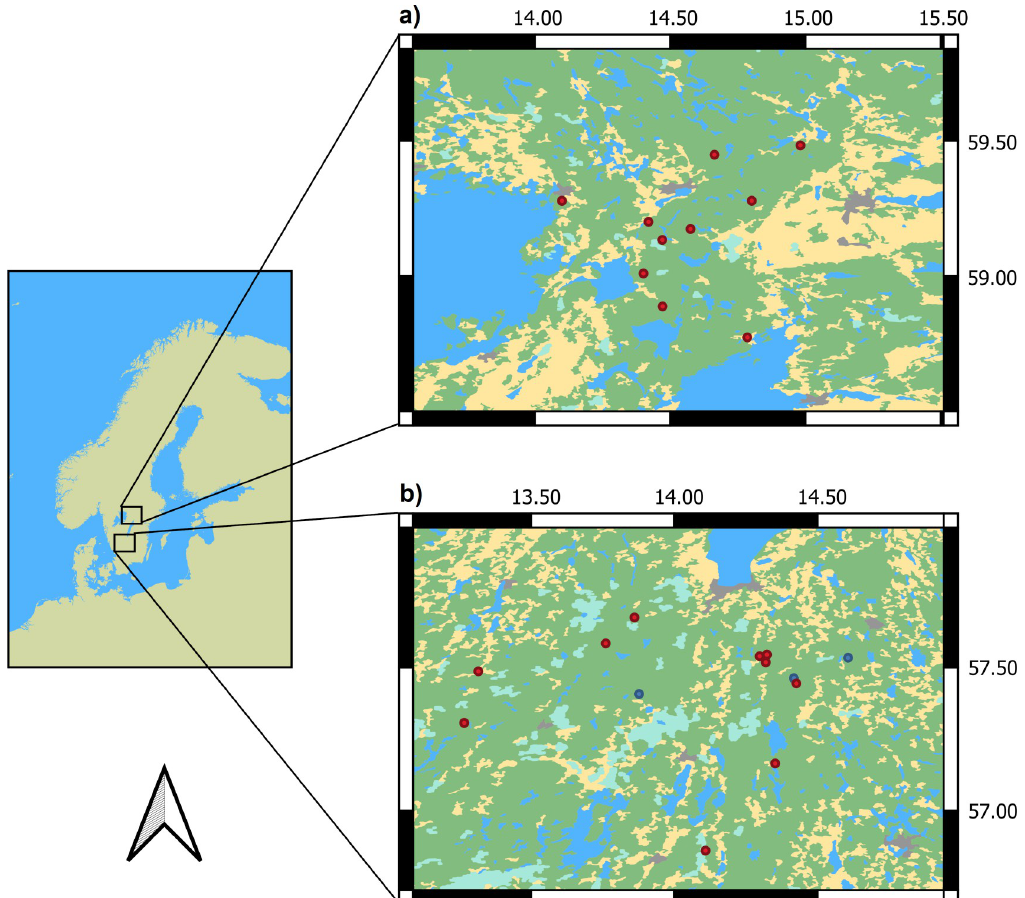
Fig 1. Map of study sites. a) Study sites in the northern region, corresponding roughly to O¨rebro county. Each red dot represents a study site consisting of one thinned production stand, one unthinned production stand and one Woodland Key Habitat stand. b) Study sites in the southern region, corresponding roughly to Jo¨nko¨ping county. Each red dot represents a study site consisting of one thinned production stand and one Woodland Key Habitat stand. Blue dots represent unpaired nature reserve stands. Green is forested land, teal is wetland, yellow is open (agricultural) land, and grey is urban land. Coordinates are in WGS84, with decimal degrees as units. Background map provided by [47].